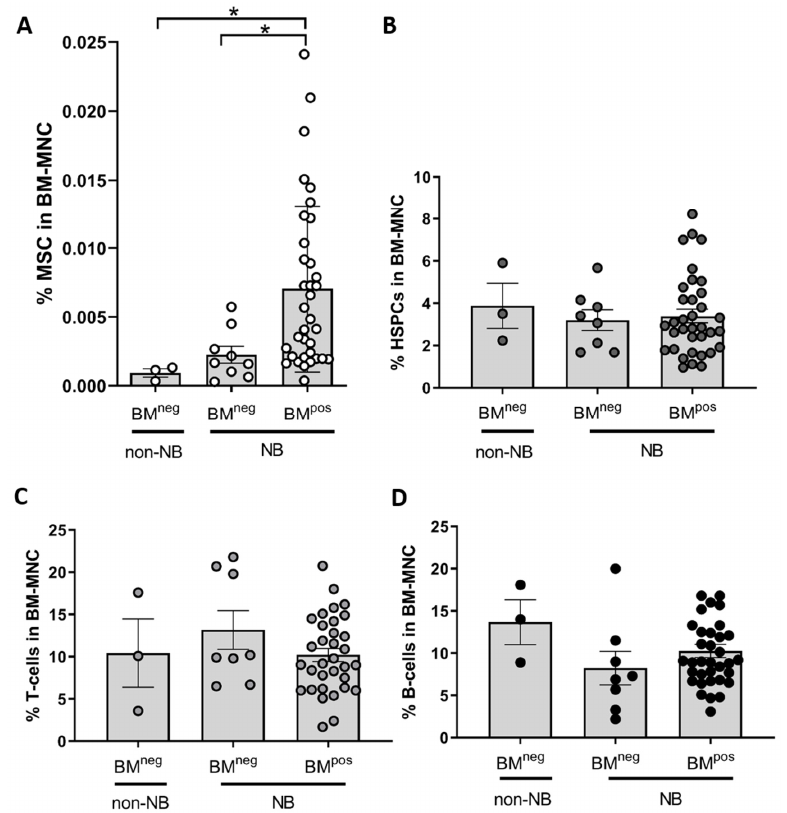
Figure 1. The MSC-frequency is significantly increased in bone marrow with versus without metastases. The frequency of 4 different BM cell populations relative to the number of BM mononuclear cells (BM-MNC) was analyzed by flow cytometry in diagnostic BM aspirates of patients with neuroblastoma and other tumors. Metastatic disease in the BM is defined based on qPCR positivity as BM pos and qPCR negativity as BM neg . Non-NB tumors analyzed are localized ganglioneuroma (GN; n = 1), ganglioneuroblastoma (GNB; n = 1) and malignant peripheral nerve sheath tumor (MPNST; n = 1). ( A ) CD34 − , CD45 − CD90 + CD105 + mesenchymal stromal cells (MSCs) (BM pos n = 35, BM neg n = 9) ( B ) CD34-positive CD45-dim hematopoietic stem and progenitor cells (HSPCs) ( C ) CD3-positive T-cells and ( D ) CD19-positive B-cells. For B-D: BM pos n = 35, BM neg n = 8. Only statistically significant results as determined by Kruskal-Wallis test are indicated: (*) p <